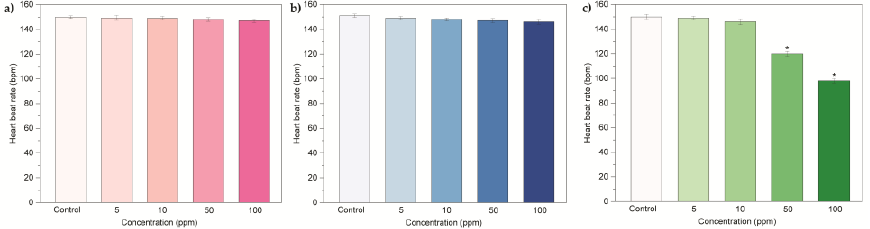
Figure 6. Heart beat rate of zebrafish treated with ( a ) oxi-CNOs, ( b ) oxi-CNHs and ( c ) GO. Values are expressed as means ±S.D.